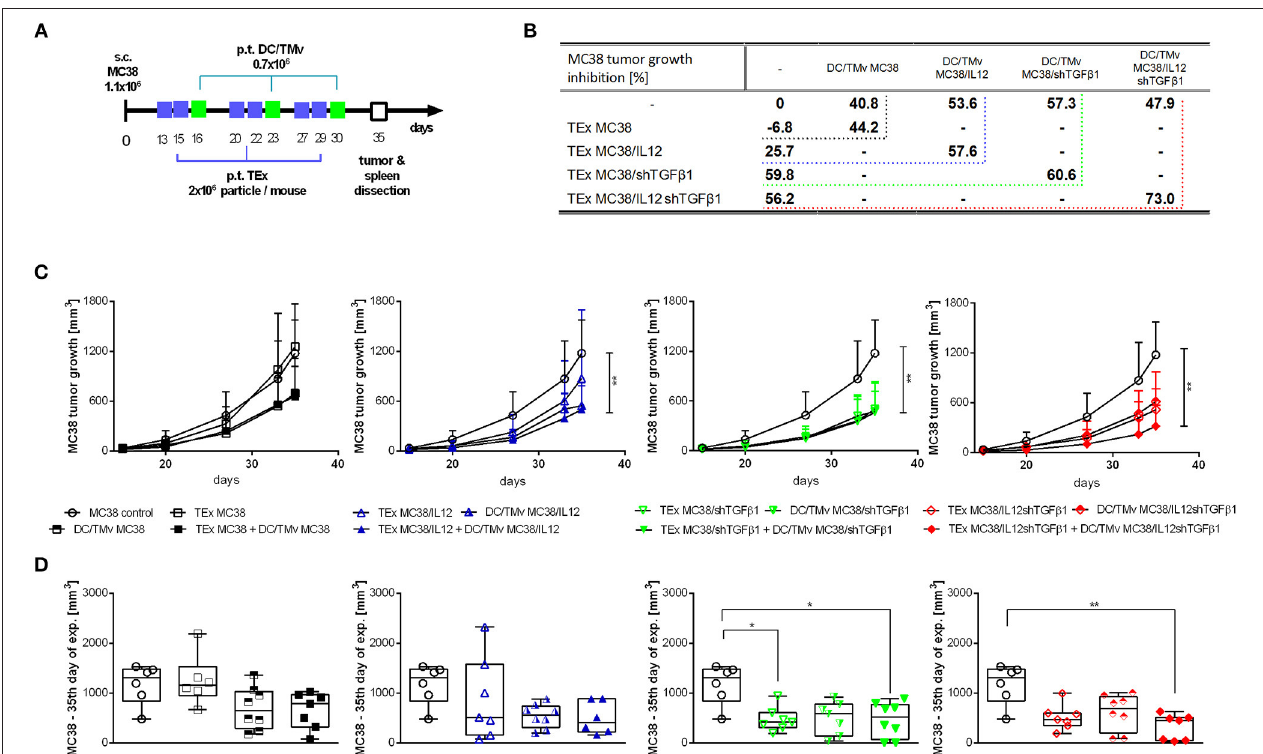
FIGURE 4 | MC38 tumor growth after immunotherapy with mTEx and/or dendritic cells stimulated with mTMv. (A) Scheme of treatment. (B) Table presenting MC38 tumor growth inhibition (TGI) calculated on the 35th day of the therapeutic experiment in relation to the untreated group. (C) Curves presenting the mean tumor volume after immunotherapy. The differences between groups were estimated using the Friedman test (** p < 0.01). (D) The box graphs present the median tumor volume, calculated on the 35th day. To calculate the mean ± SD, 6–8 mice per group were analyzed. The differences between the groups were estimated using the nonparametric Kruskal-Wallis test followed by Dunn’s multiple comparison test (* p < 0.05, ** p <